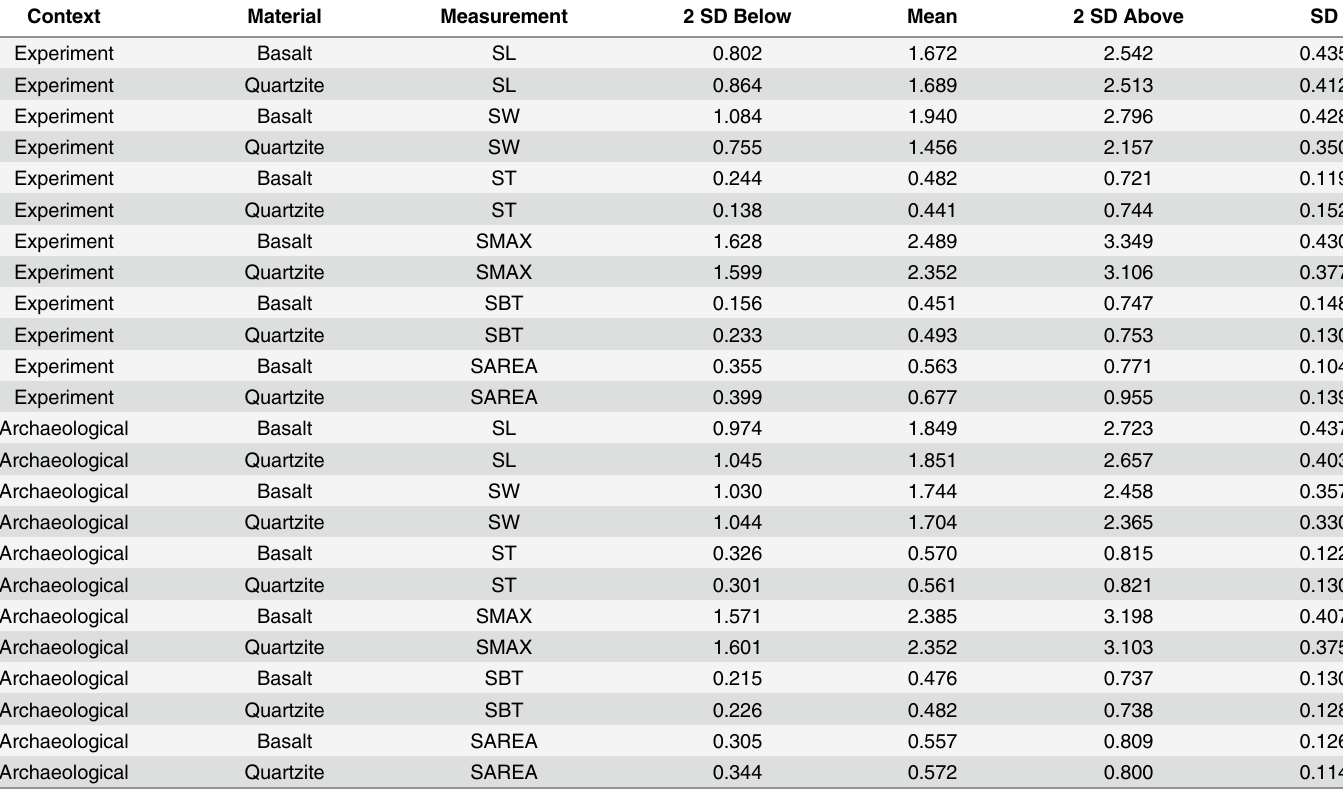
Table 4. Distribution of assemblage variation for each measurement and raw material for experimentally produced flakes. (SL: Size-Standardized Length; SW: Size-Standardized Width; ST: Size- Standardized Thickness; SMAX: Size-Standardized Maximum Dimension; SBT: Size-Standardized Bulbar Thickness; SAREA: Size-Standardized